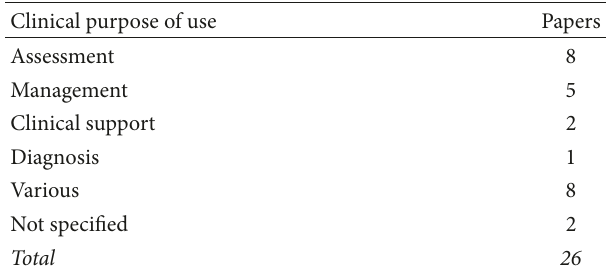
Table 3: Designs of identified